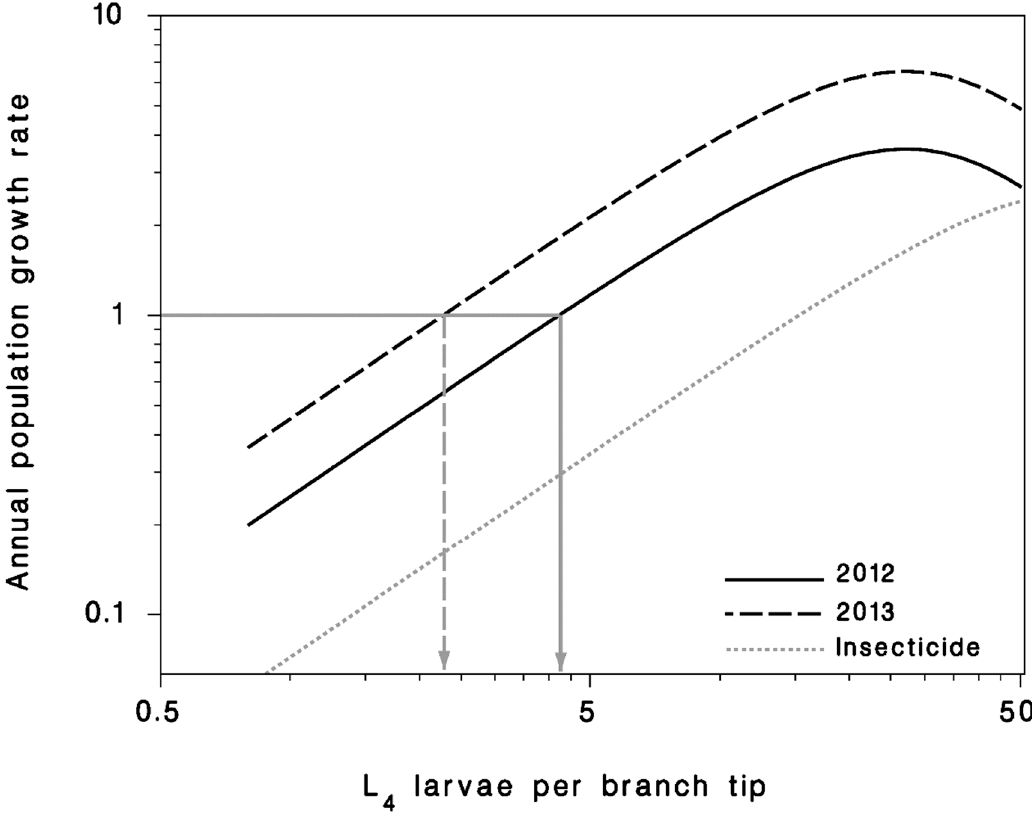
Figure 10. Relationship between expected population growth rate and density of feeding larvae (L 4 ) early in the development of a new spruce budworm outbreak (solid line: 2012, dashed line: 2013). Grey dotted line represents growth rate of populations treated with an insecticide (here, Btk in 2013). Grey downward arrows point to threshold densities for population increase, where R = 1 (4.3 and 2.3 L 4 larvae per branch tip in 2012 and 2013, respectively).